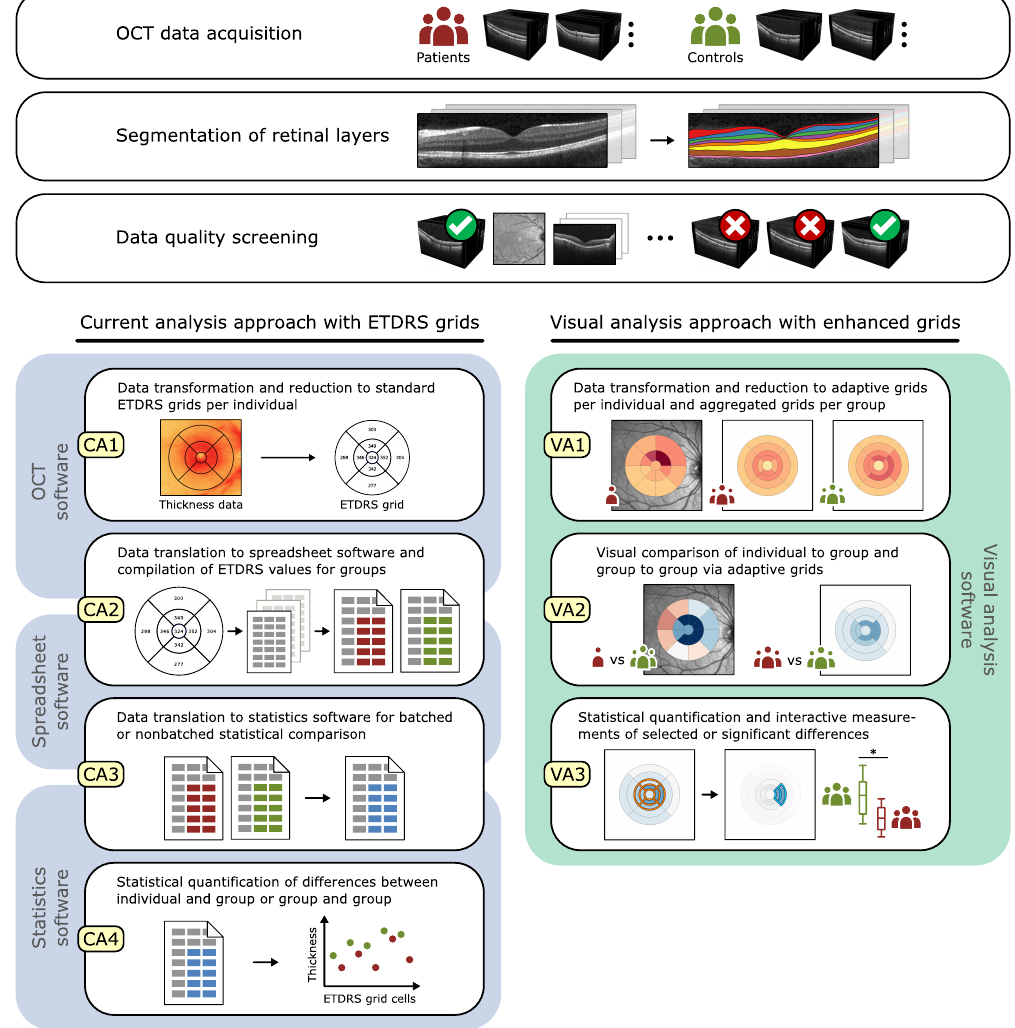
Figure 9. Exemplary procedures for evaluating cross-sectional ophthalmic study data using an ETDRS-based analysis approach (CA) and an enhanced grid-based analysis approach (VA). After a common data preparation stage, CA comprises four analysis steps ( CA1–CA4 ) with three software tools and VA involves three analysis steps ( VA1–VA3 ) with our visual analysis